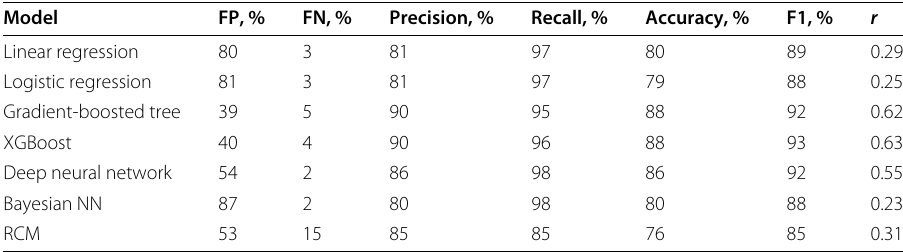
Table 4 Evaluation results without reading